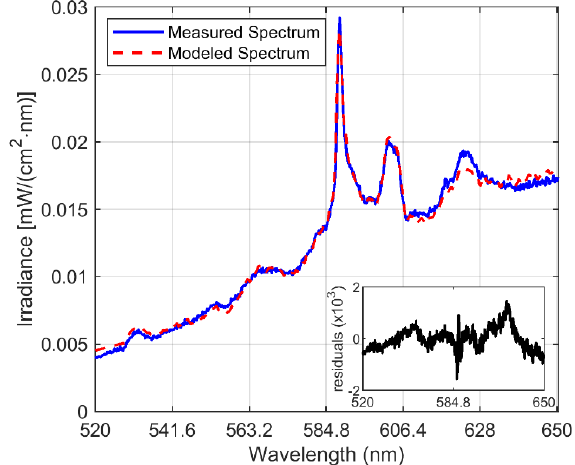
Figure 9. Non-linear curve fitting results for a spectrum from combustion of PyE sample, RMSE (root mean square error) = 0.4393, θ 0 = 0.0249, T s = 2220.3 K, θ 1 (related to I 1 or Na) = 3.4583, θ 2 (related to I 2 or Na) = 15.7373, θ 3 (related to I 3 or FeO) = 6.2484, θ 4 (related to I 4 or Fe 3 O 4 ) = 7.3093 and θ 5 (related to an o ff set) = 9.6 × 10 − 8 .